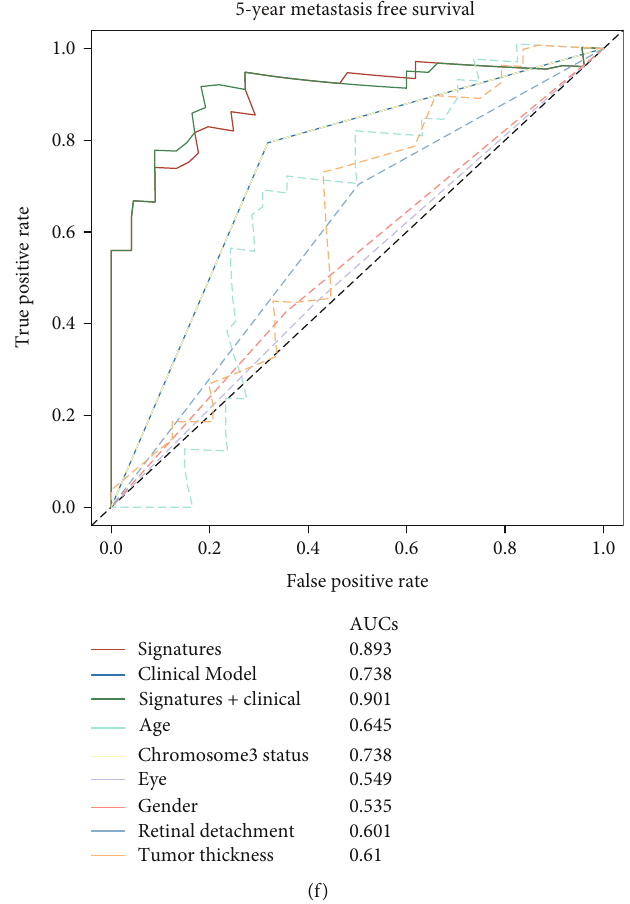
Figure 4: Survival analysis, prognostic performance, and clinical utility of UMPS in the training cohort. (a) Risk score distribution of the training cohort. (b) Survival overview. (c) Heatmap showing the expression of the 8 genes in the low-risk and high-risk groups. (d) Survival curve of the low-risk and high-risk groups by Kaplan-Meier survival analysis. The high-risk group had worse metastasis-free survival than the low-risk group. (e, f) Time-dependent receiver operating characteristic (ROC) analysis for comparing the performance of UMPS with the clinicopathological factors. The AUC of UMPS was higher than the single clinicopathological factor in prediction 3-y and 5-y metastasis-free